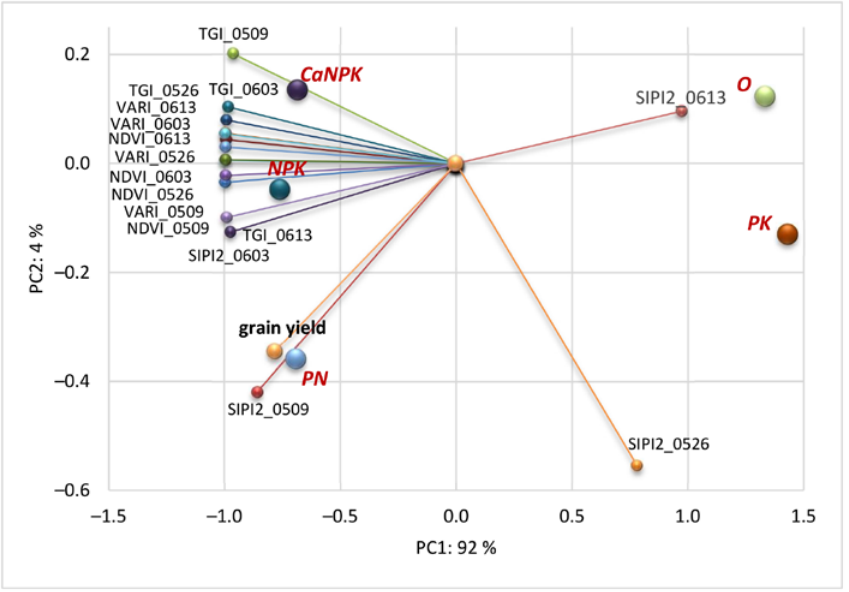
Figure 3. The results of PCA presenting multivariate differences between treatments and relationships between selected vegetation indices in various terms (e.g., 0509 indicates 5 May) and grain yield in Experiment 1 (crop rotation without legumes and only mineral fertilization). Abbreviations: TGI—Triangular Greenness Index, SIPI2—Structure Insensitive Pigment Index 2, Ca—calcium, N— nitrogen, P—phosphorus, K—potassium.